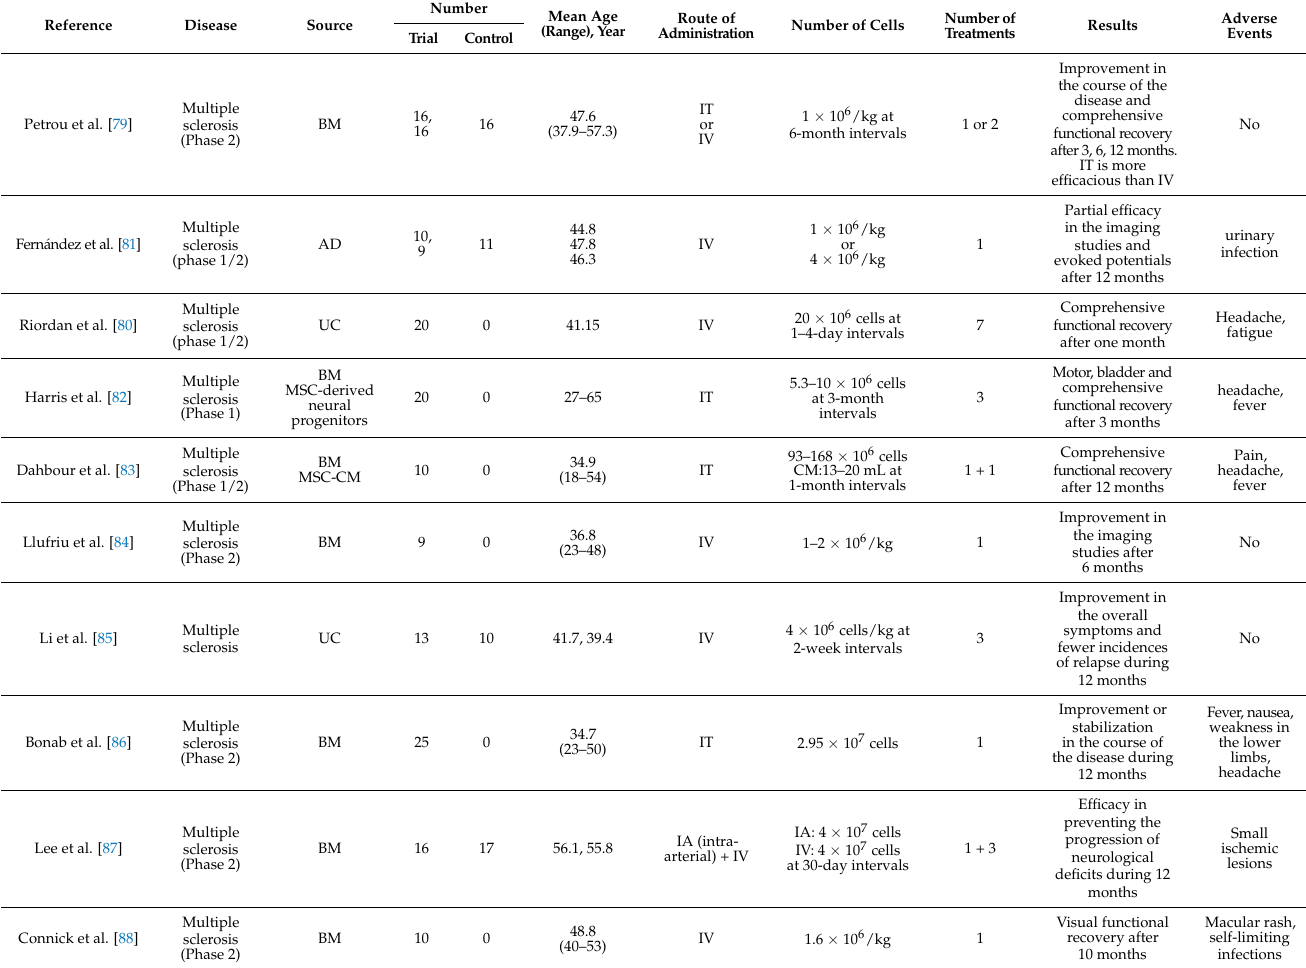
Table 5. Summary of recent clinical trials using MSCs for multiple